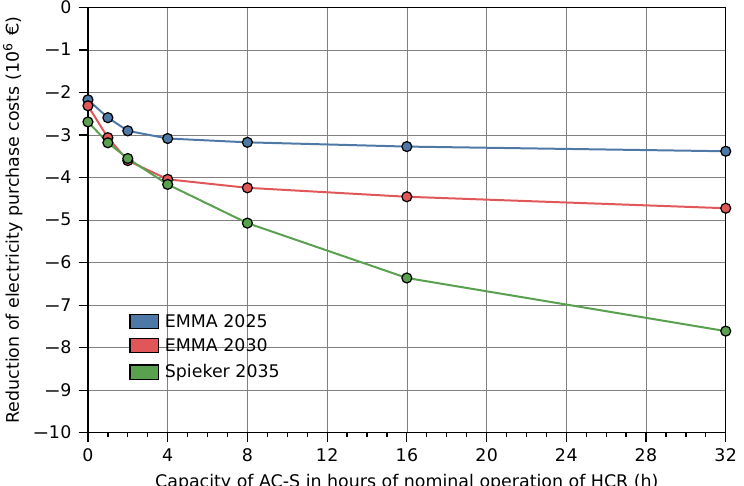
Figure 7. DR savings without balancing power service, 120MW, 2025, 2030, 2035 based on modelled spot prices.